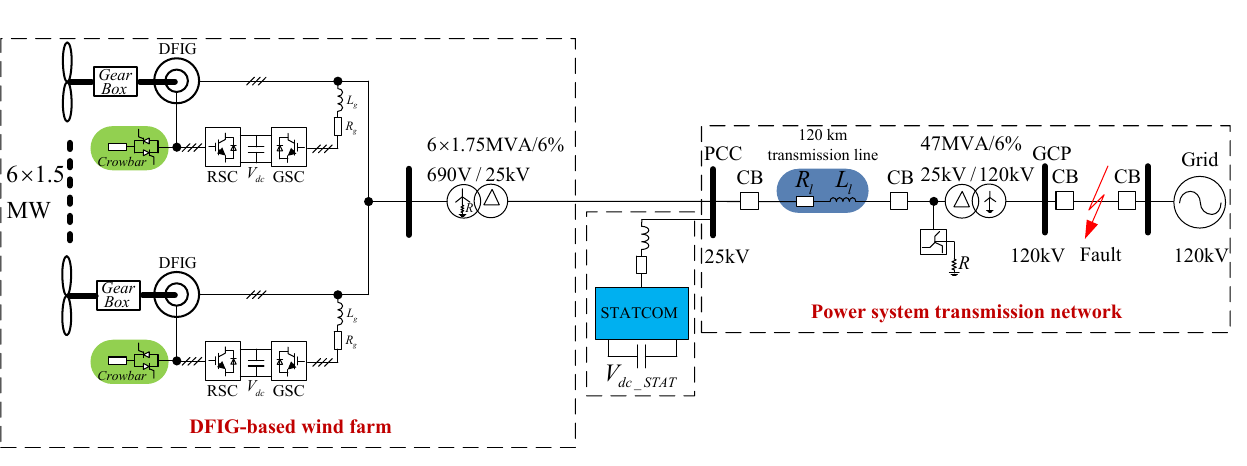
Figure 5. A grid-connected DFIG-based wind farm equipped with a static synchronous compensator